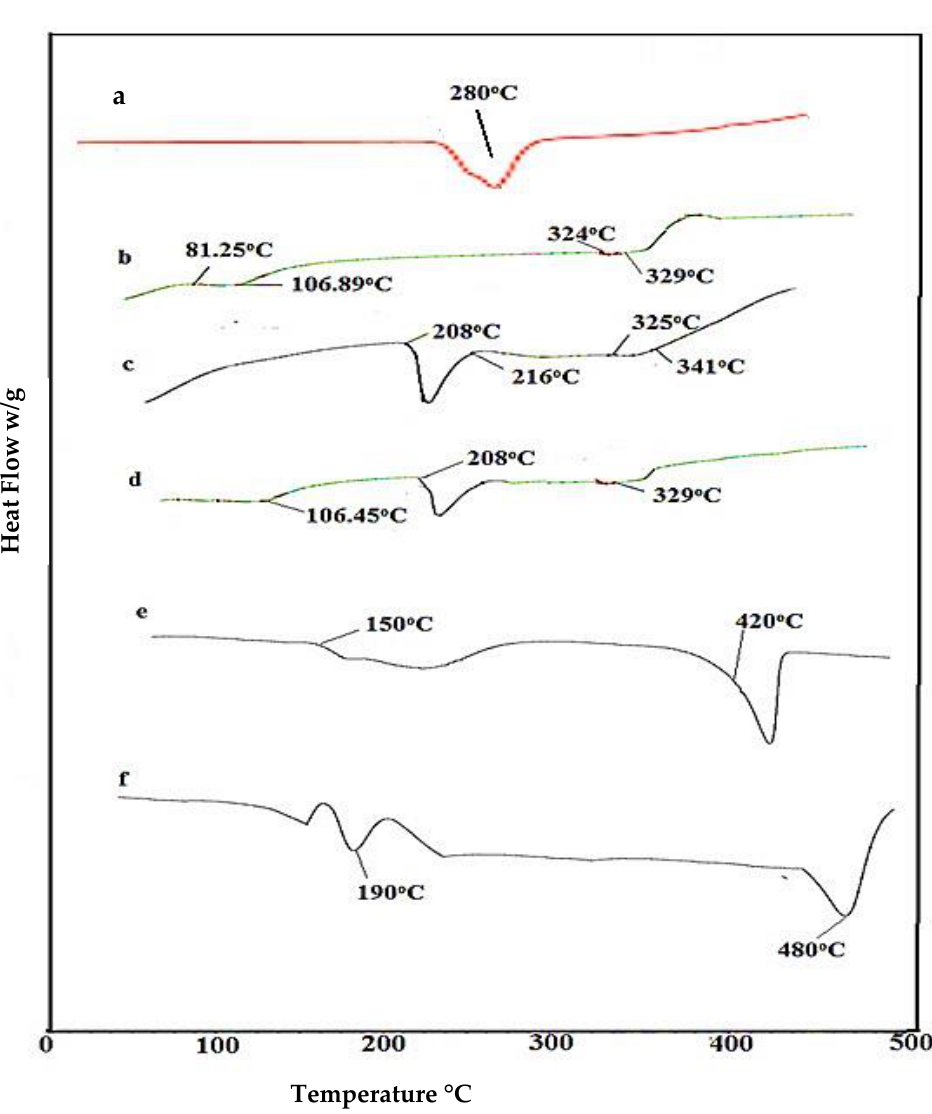
Figure 4. DSC thermogram of ( a ) Carboxymethyl chitosan (CMC), ( b ) β -CD, ( c ) AMPS, ( d ) physical mixture, ( e ) βCD -co-. Poly (AMPS), and ( f) βCD -CMC-co-poly (AMPS) nanosponges.